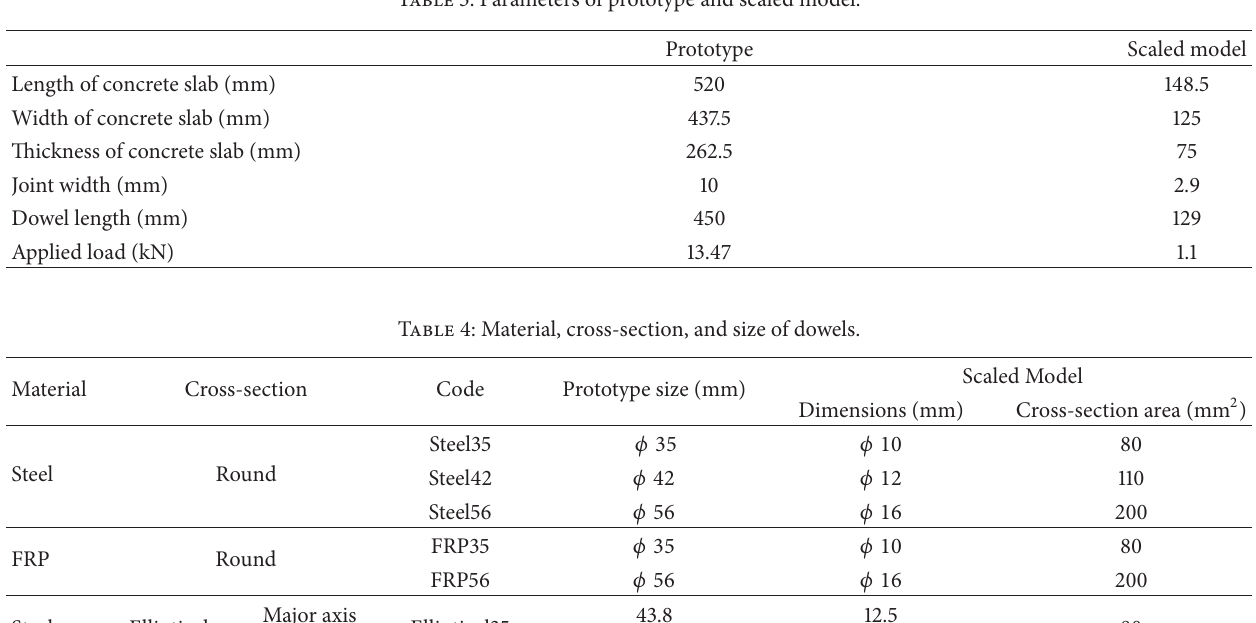
Table 3: Parameters of prototype and scaled model.